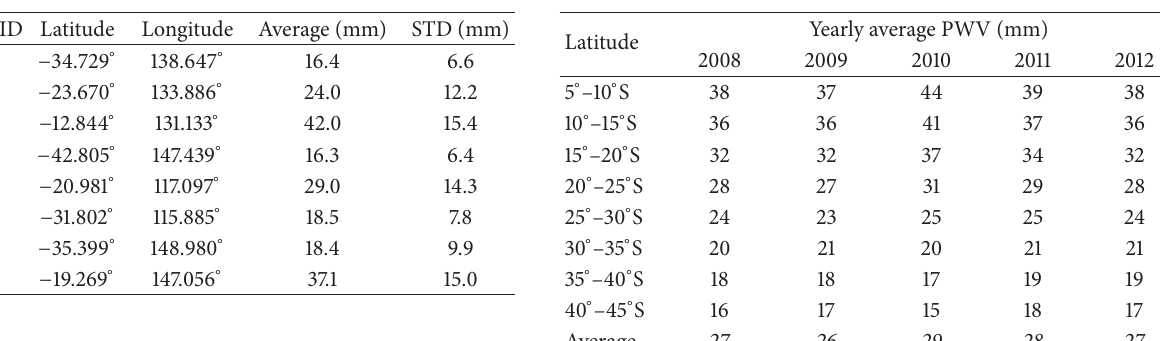
Table 7: A five-year average of GPS PWV estimates and standard deviations (mm) at the eight GPS sites.